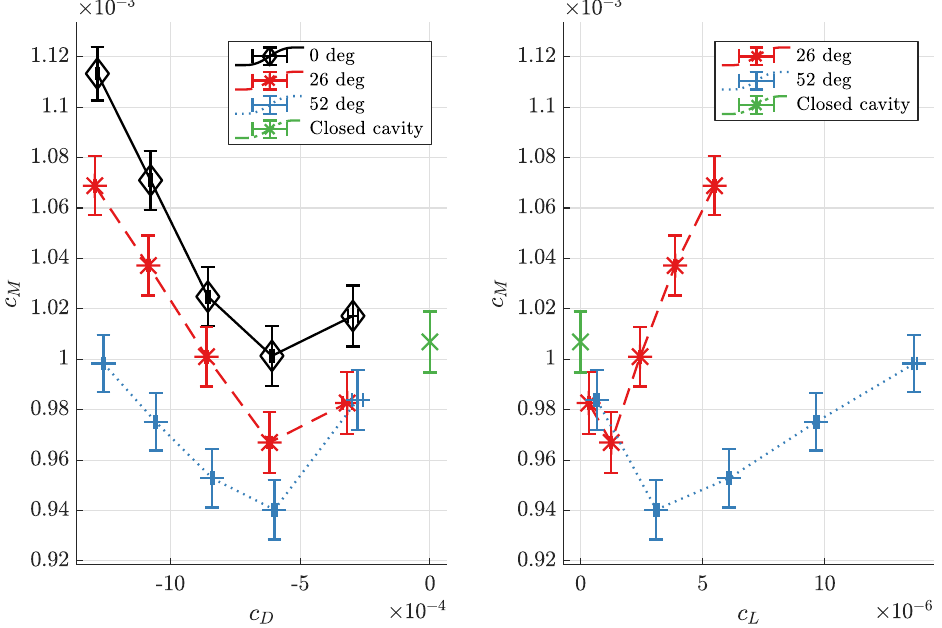
Figure 5. Change of measured torque coefficients c M with through-flow coefficient c D and angular momentum coefficient c L at the relative gap width of G = 0.0125 and in the Reynolds number range of 7.5 10 7 9.6 10 7 : the closed cavity configuration is compared to centripetal through-flow at Re × ≤ ≤ × preswirl angles of 0°, 26° and